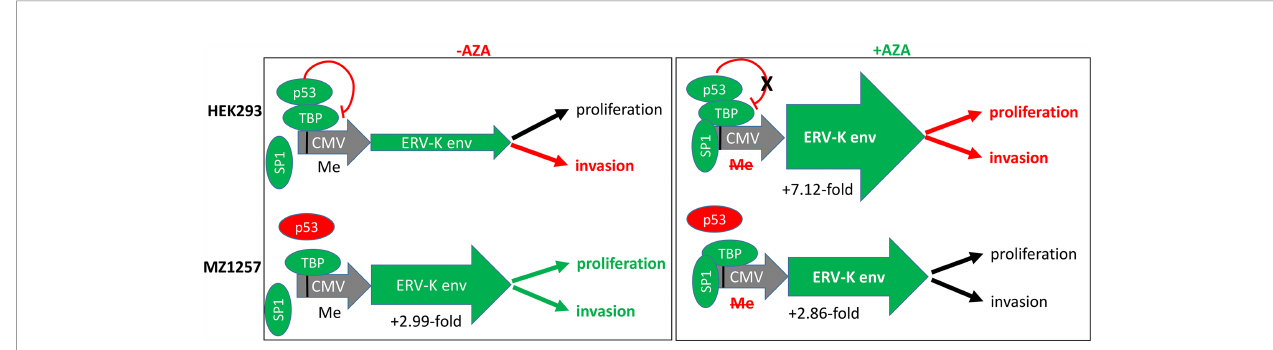
FIGURE 6 | Results and model showing transcriptional regulations and cellular functions of HEK293 and MZ1257RC cell lines following ERV-K113 env gene transfection in the presence or absence of Aza treatment. Left schematic shows top HEK293 cells or bottom MZ1257RC cells transfected with the overexpressing CMV vector containing a codon optimized ERV-K113 env gene in the absence of Aza (-Aza). The CMV promoter (grey) with p53 binding to TATA binding protein (TBP) (38) is methylated (Me). Note that the transcription factor SP1 is not bound. The p53 wt protein is a repressor (green) for HEK293 cells, but mutant (dysfunctional) p53 (red) for the MZ1257RC cell line. For HEK293 cells the green arrow (ERV-K env) indicates less expression, when compared with MZ1257RC cells. A 2.99-fold increase of ERV-K113 env gene expression for MZ1257RC (2 - DD Ct = -Aza = 3,113.2) is indicated compared to HEK293 cells (2 - DD Ct = -Aza = 1,038.5) at 24 h post transfection. Right schematic shows top HEK293 cells or bottom MZ1257RC cells transfected with the overexpressing CMV vector containing a codon optimized ERV-K113 env gene in the presence of Aza (+Aza). P53, TBP and SP1 (40) are bound at a de-methylated CMV promoter (grey) promoting transcription. In the presence of Aza an inhibition of DNA-methylation (Me) and a lack of p53 repression is predicted for HEK293 cells. For both cell lines ERV-K113 env green arrows indicate higher levels of expression when compared to – Aza treated cells (left schematic). ERV-K113 env gene expression for HEK293 was 7.12- fold higher (2 - DD Ct = +Aza = 7398.7) and for MZ1257RC cells a 2.86-fold induction (2 - DD Ct = +Aza = 8927.69) at 24 h. Note that for both cell lines the 2 - DD Ct ERV- K113 env gene expression levels were similar at 24 h after Aza treatments. To the far right for both cell lines functional outcomes are indicated for proliferation (at 44 h, 68 h, 92 h) and invasion (68 h), when compared to in the presence or absence of Aza treatment (see Figure 5 , Supplementary Figure 2 ) (black arrows = no change; red arrows = inhibition; green arrows =